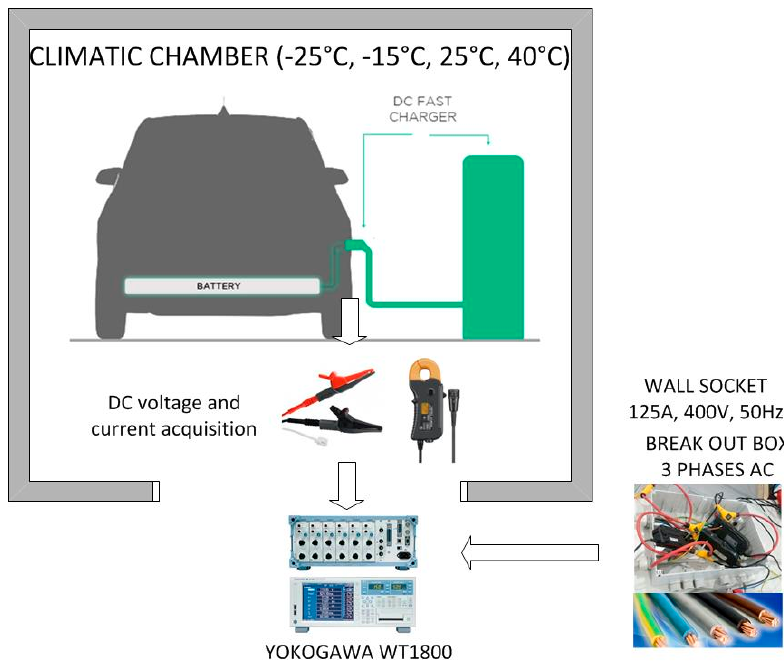
Figure 1. Joint Research Center (JRC) VeLa 8 test set-up.